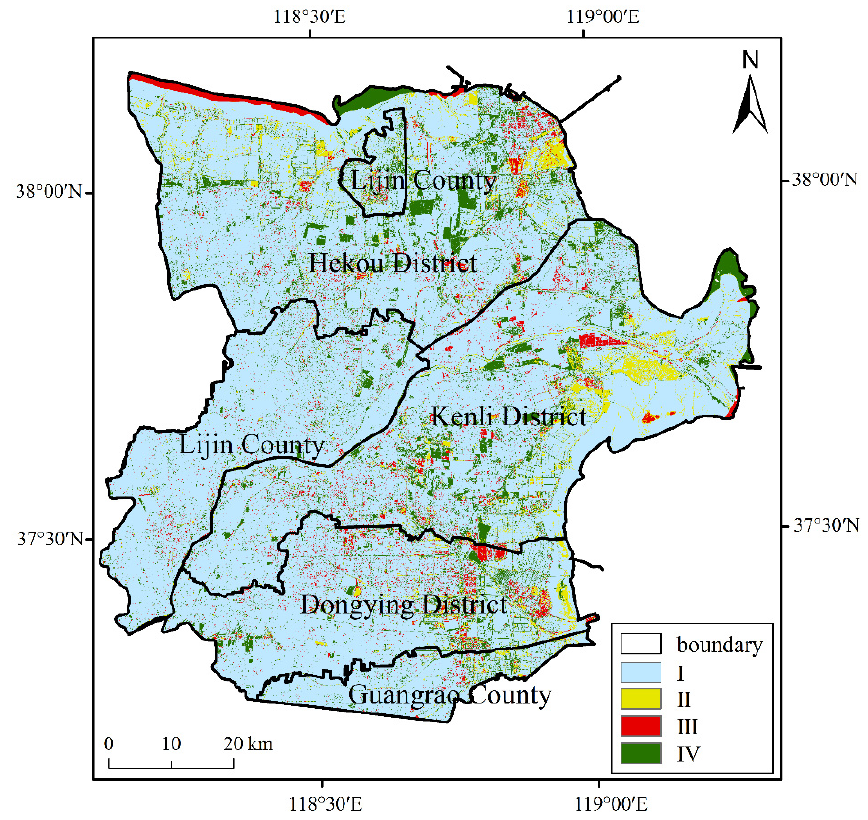
Figure 7. Spatial distribution of primary classification changes in land cover. Ⅰ Unchanged area; Ⅱ Internal conversion area; Ⅲ Extinction area; Ⅳ New-born area. Table 7. Comparison of primary classification change patterns.